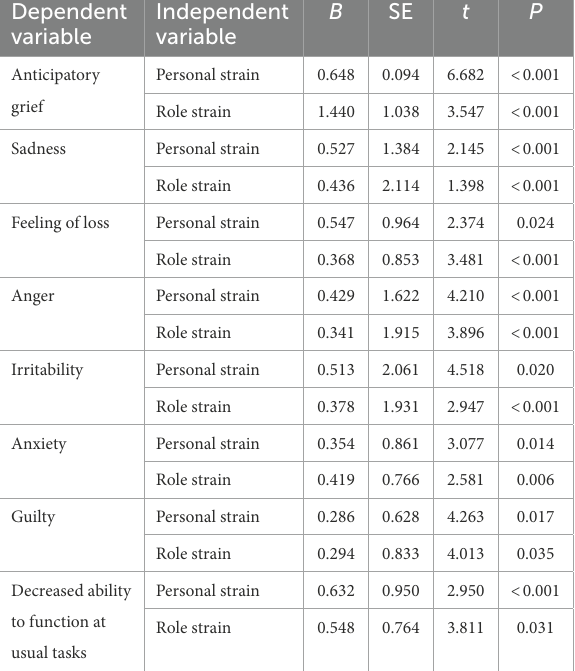
TABLE 3 Multiple regression analysis of each dimension of caregiver burden to anticipatory grief (age, relationship with patients were statistically